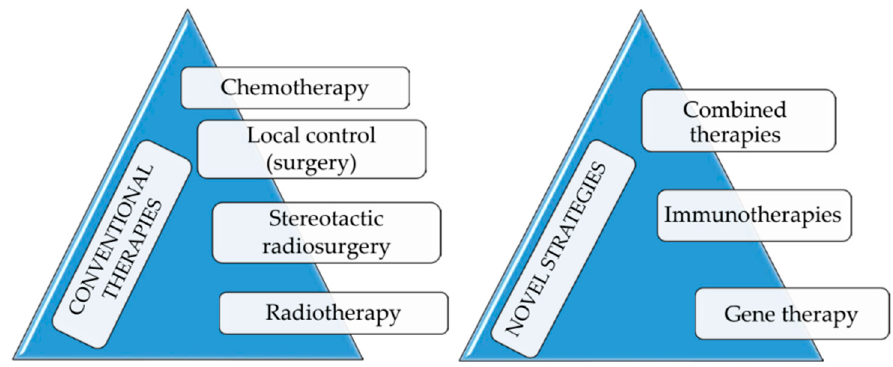
Figure 2. Conventional and innovative approaches to canine OSA treatment.